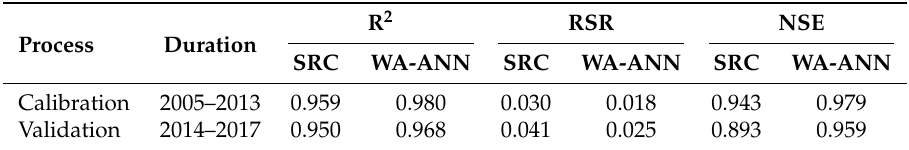
Table 7. Statistical performance of HEC-RAS model with the SRC and WA-ANN techniques during the calibration and validation